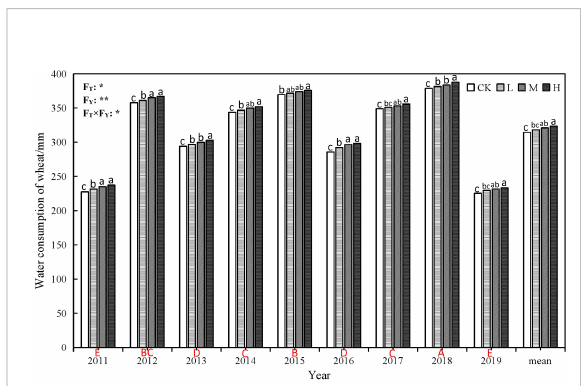
absorbent polymer and precipitation from 2011 to 2019. CK, 0 kg ha-1; L, 15 kg ha-1; M, 30 kg ha-1; H, 45 kg ha-1. Different lower-case letters above columns indicate signi fi cantdifferences between four treatments in the same year by Scheffe ́ test (P< 0.05). Different upper-case letters under columnsindicate signi fi cant differences between mean value of fourtreatments in different years by Scheffe ́ test (P< 0.05). FT, FY andFT×FY mean F-values of treatments, years and their interactionsin variance analysis respectively. “ * and ** ” indicate difference atthe 0.05 and 0.01 levels, respectively.